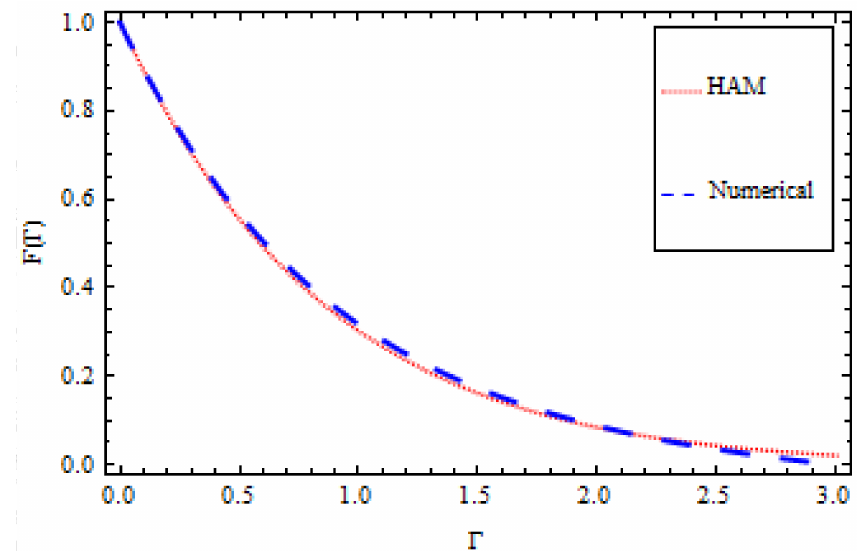
Figure 14. HAM and numerical comparison for velocity profile F (cid:48) ( Γ )